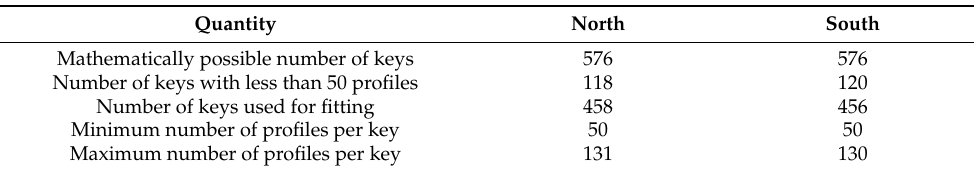
Table 7. Statistical information about the interval keys of the test dataset for the Northern and Southern Hemispheres.